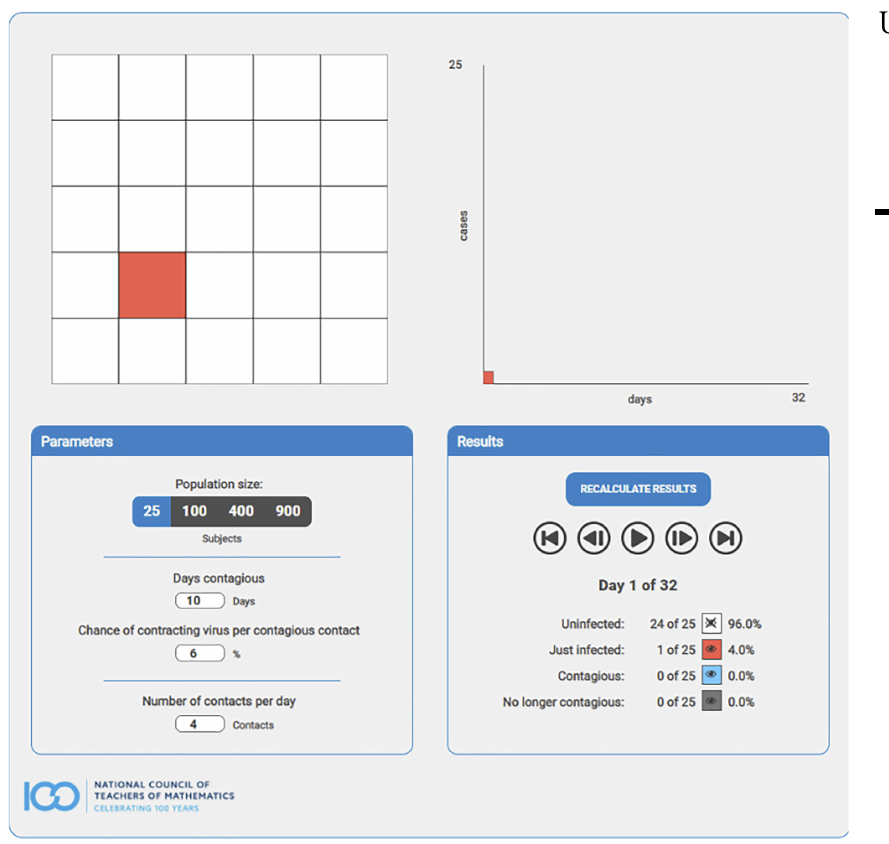
Figure 3. Simulation of